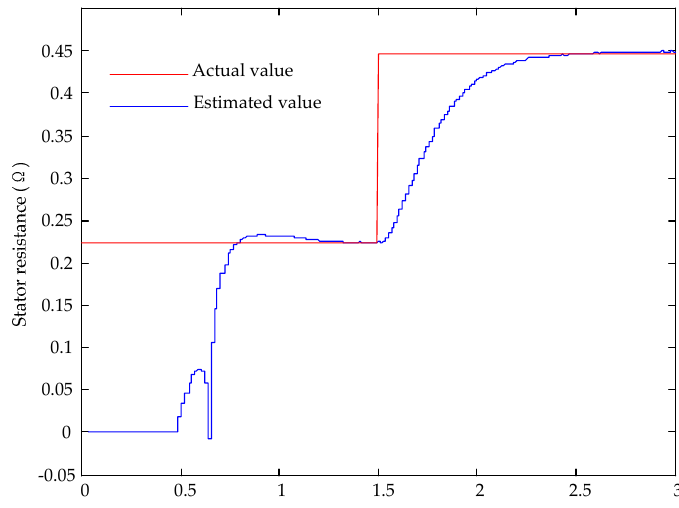
Figure 14. Estimated stator resistance of the IM using the DC signal injection method, where the stator resistance was changed at t = 1.5 s.